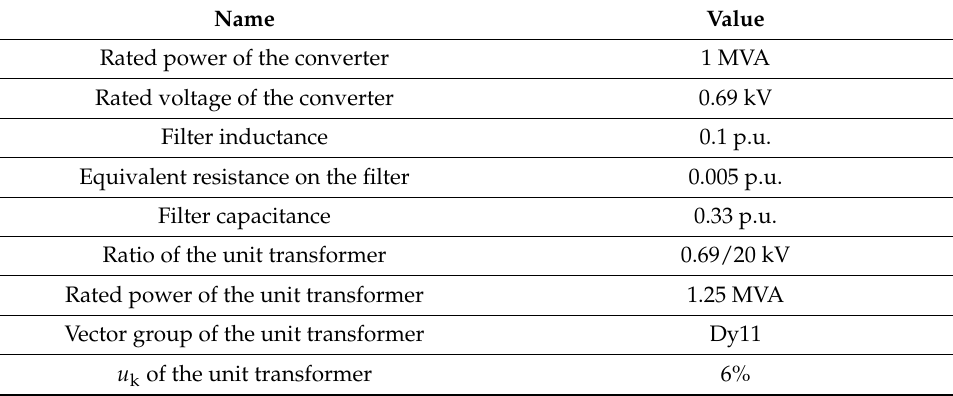
Table 3. Hardware parameters.